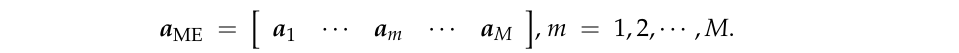
Figure 2. Procedure of the proposed kinematic ME-MAFA algorithm.